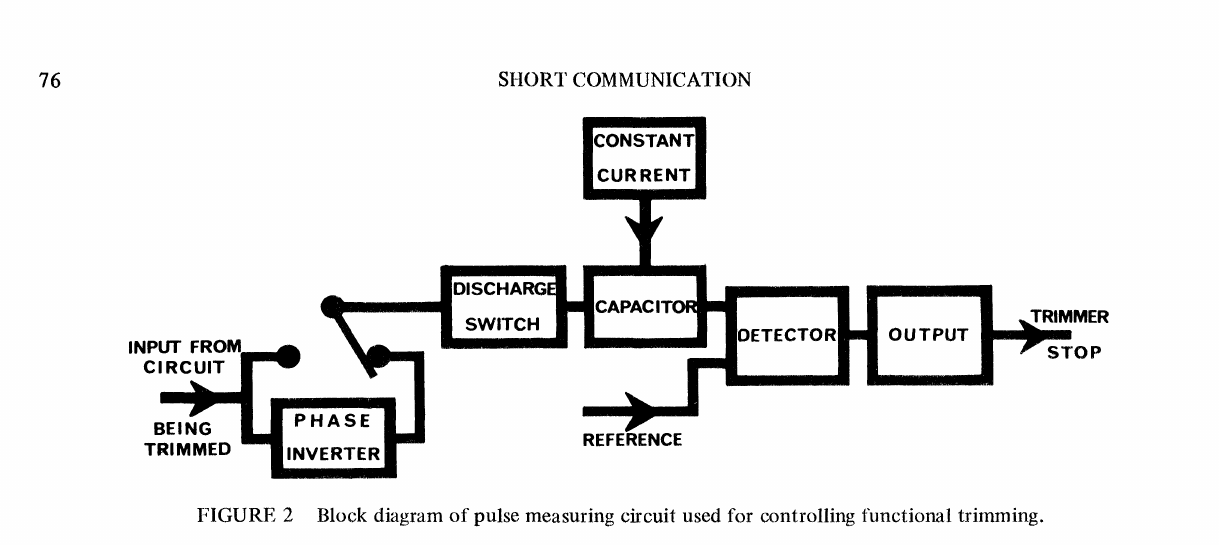
FIGURE 2 Block diagram of pulse measuring circuit used for controlling functional